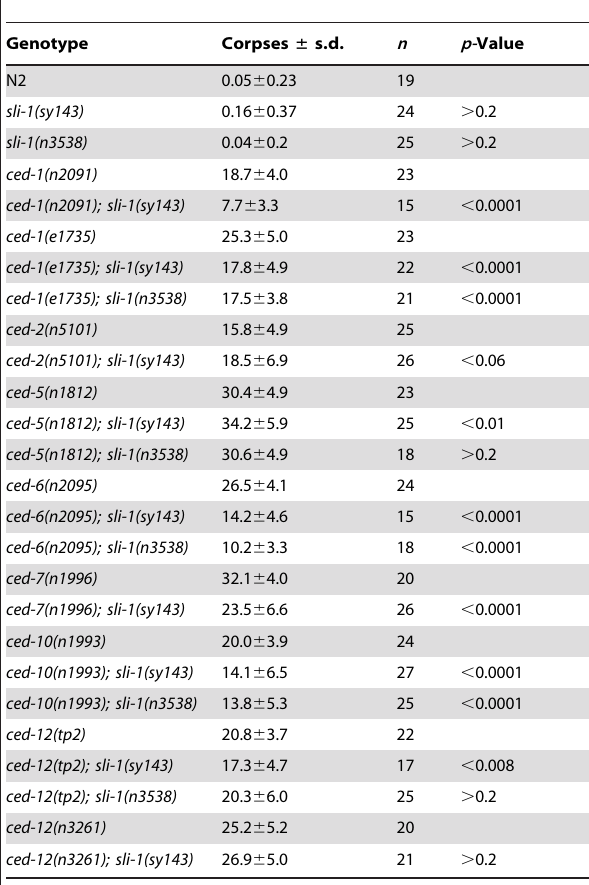
Table 1. sli-1 mutations suppress the engulfment defects caused by engulfment ced gene